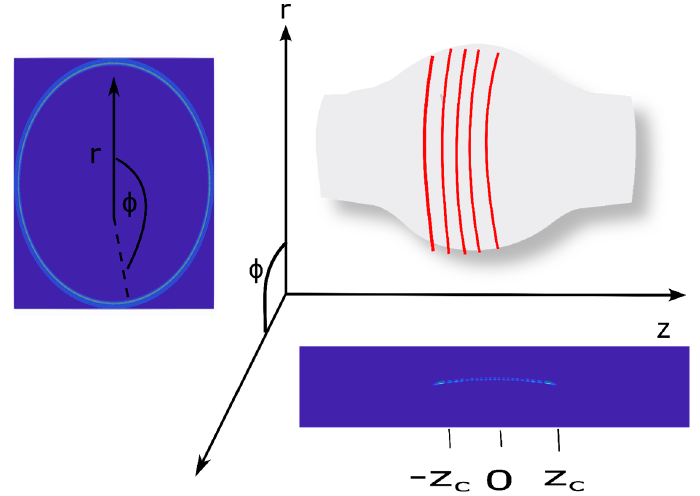
Figure 1. Microbo tt le resonators’ light con fi nement. Figure 1. Microbottle resonators’ light